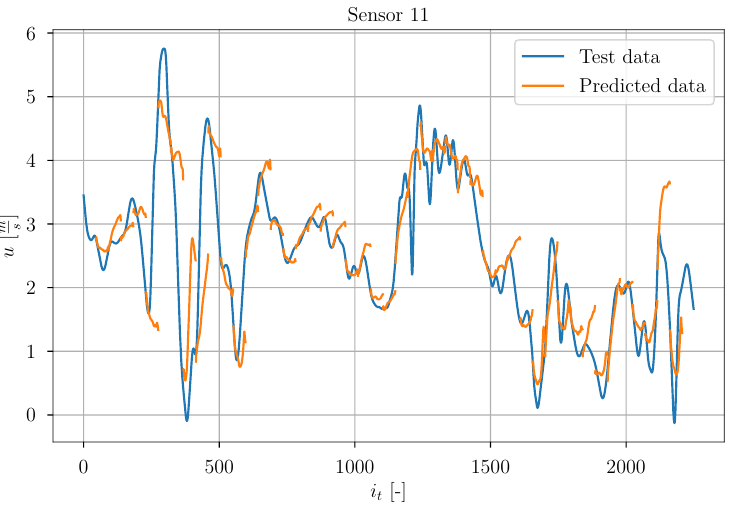
Figure 42. Predicted and true timeseries of sensor 11 for adjusted n in and n out . The presented data is discontinuous to illustrate the windows size.